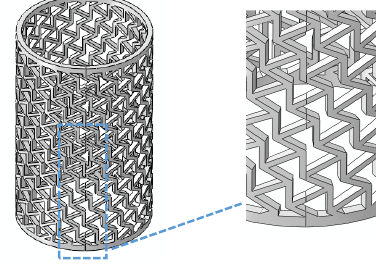
Figure 3. The joints of θ 1 RHCSs.